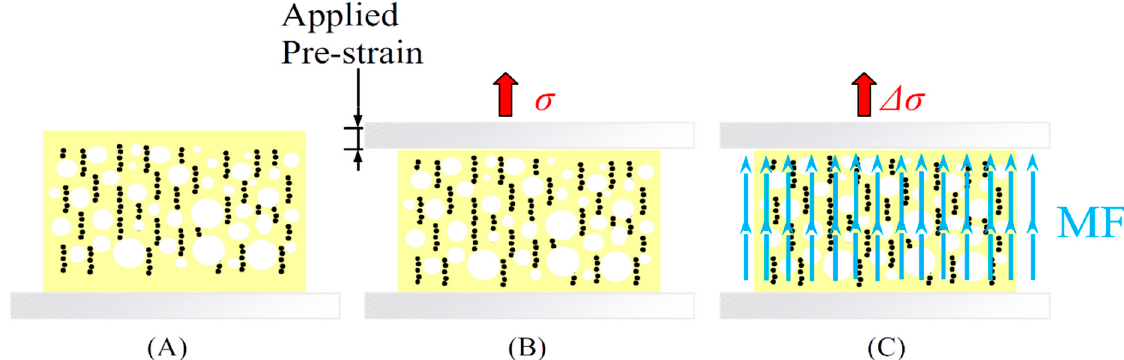
Figure 2. Magnetoelastic test steps: ( A ) sample positioning, ( B ) prestrain application and stress evaluation ( σ ), ( C ) stress change evaluation ( ∆ σ ) under the sinusoidal magnetic field (MF).